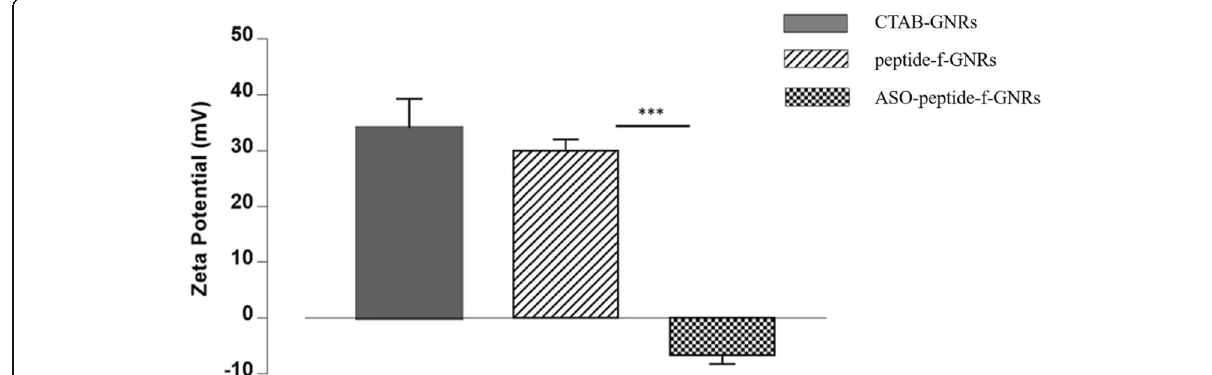
Fig. 2 Zeta potential of CTAB-GNRs (+35mV), peptide-functionalized GNRs (+29mV), and antisense oligonucleotides (ASO-conjugated GNRs ( − 6mV). The results represent the mean and standard deviation (sd) of three independent experiments (*** P